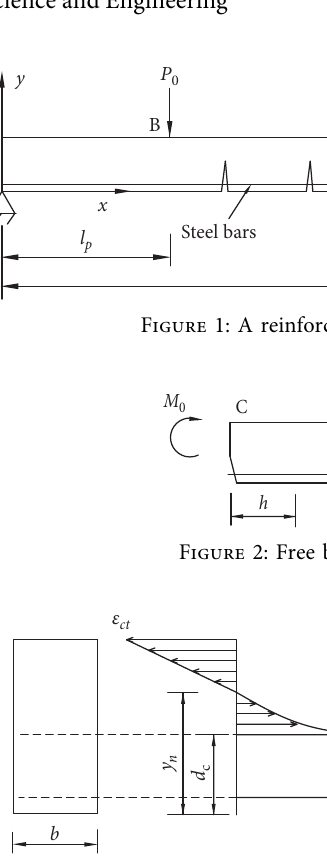
Figure 3: Models of strain distribution in the three sections: (a) Section 1; (b) Section 2; (c) Section